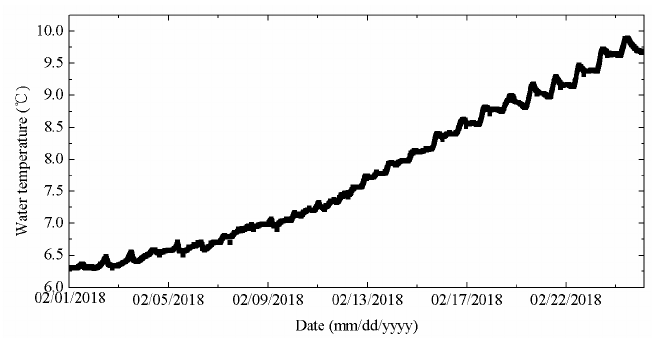
Figure 16. Water temperature measured by TYUT thermistor string from 1 February to 25 February.